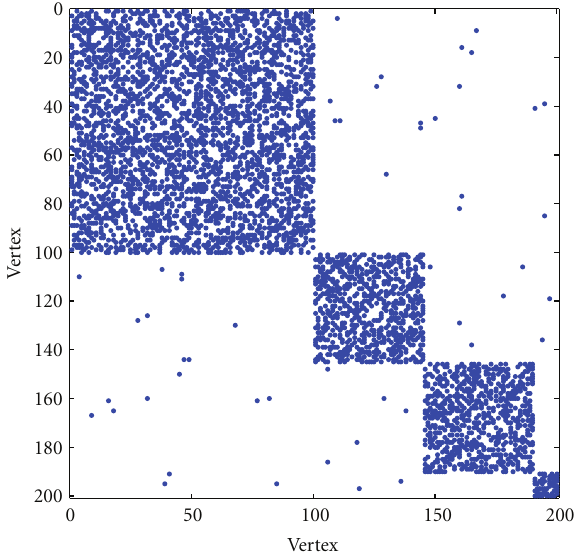
Figure 3: Pattern of the adjacency matrix for the randomly gen- erated